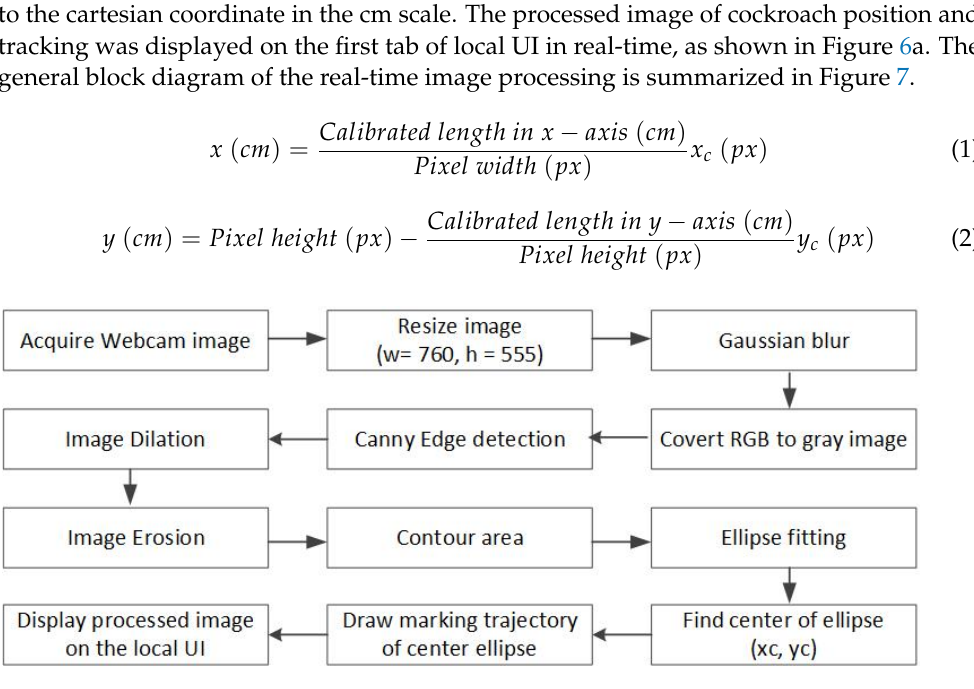
Figure 6. Local user interface in Japan: ( a ) teleoperation interface, ( b ) plotting purpose.